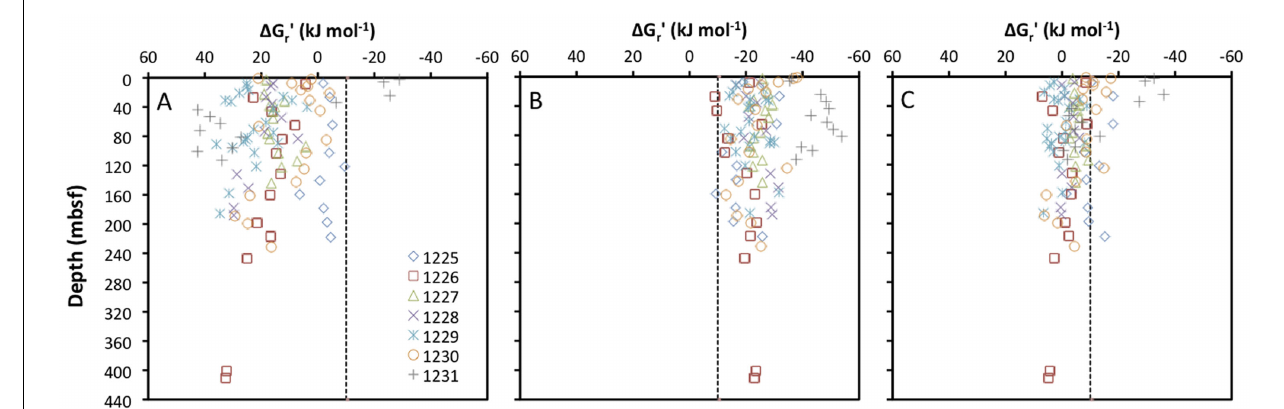
FIGURE 1 | Depth profiles of energy yields associated with acetogenesis reactions from (A) H 2 –CO 2 , (B) formate, and (C) formate–H 2 for ODP sites